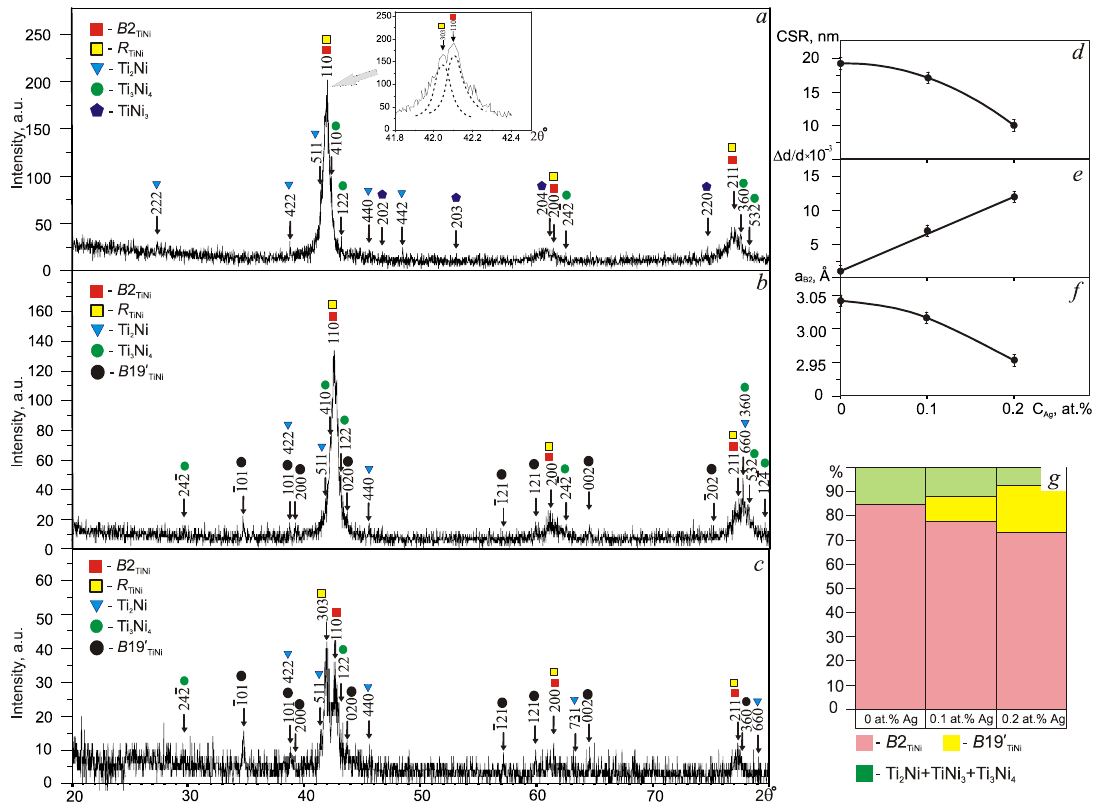
Figure 2. XRD patterns of TiNi wires with silver concentrations of 0 ( a ), 0.1 ( b ), and 0.2 at.% ( c ); concentration dependences in the parent phase on: coherent scattering regions ( d ), internal stresses ( e ), lattice parameter ( f ), phase volume fraction ( g ).